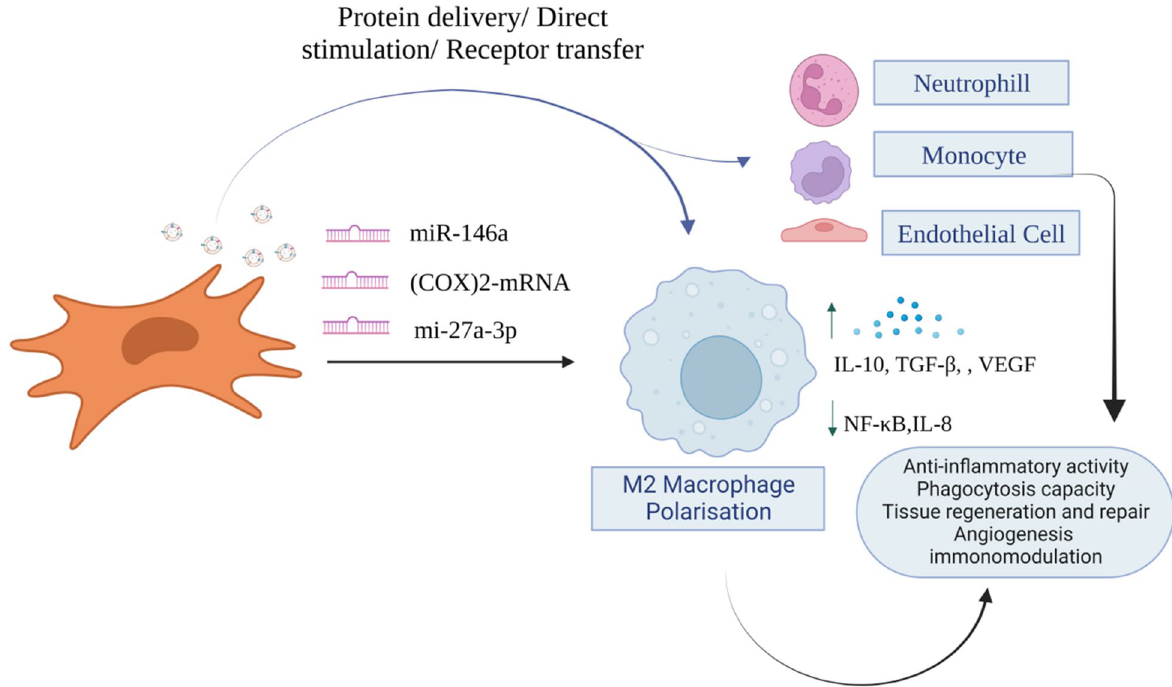
Fig. 3 MSC-EVs can produce different kinds of miRNAs causing M2 macrophage polarisation that in turn results in increased cytokine IL-10, VEGF and TGF-β and decreased NF-κB and IL-8 expression. Furthermore, the EVs are internalised into endothelial cells, monocytes, neutrophils and macrophages. As a result of which there is less pro-inflammatory cytokine production, improved phagocytic activity and increased tissue